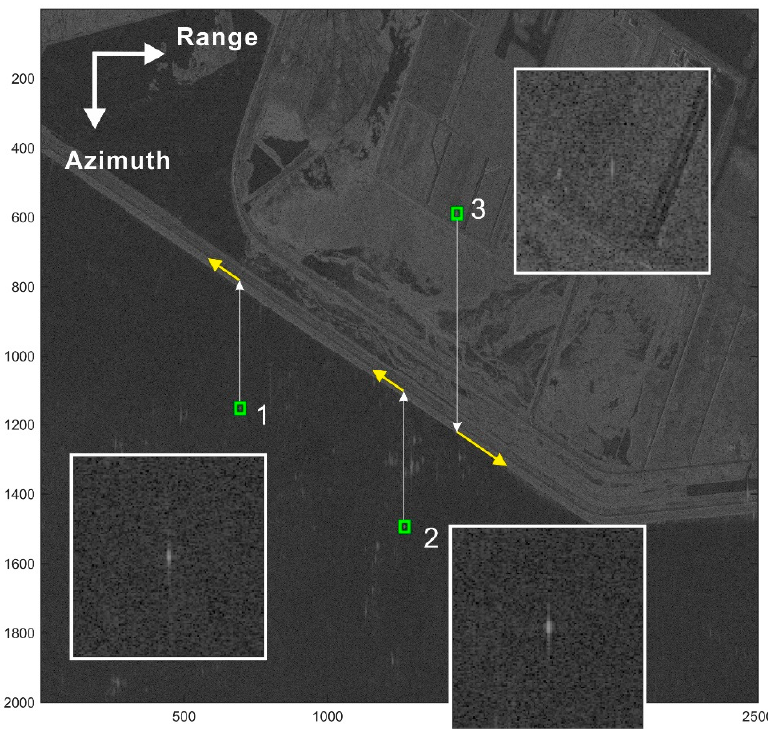
Figure 1. TerraSAR-X image of the test site and speed-controlled or GPS-measured vehicles. Green squares represent the shifted positions of the vehicle in the image, whereas the true positions are at the tips of the white arrows. The yellow arrows represent the movement direction of each vehicle. Table 2. Comparison of estimated along-track velocities before and after across-track acceleration compensation. Target